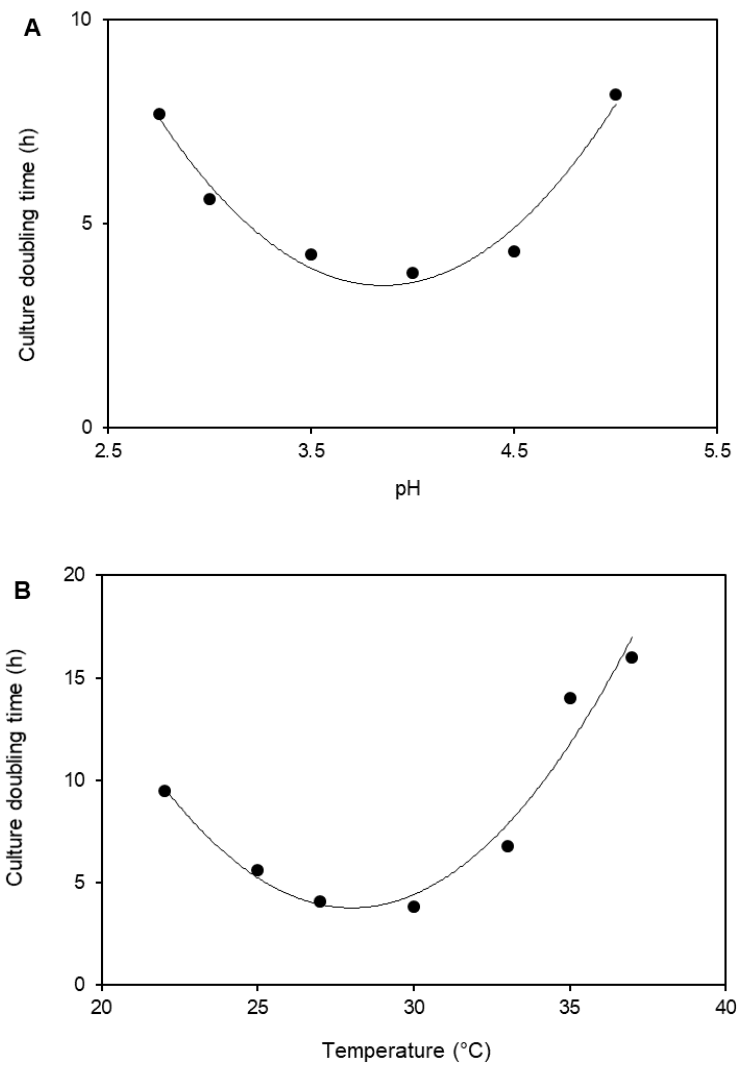
Figure 1. E ff ect of ( A ) pH (at 30 ◦ C) and ( B ) temperature (at constant pH of 4.0) on the growth of Figure 1. Effect of ( A ) pH (at 30 °C) and ( B ) temperature (at constant pH of 4.0) on the growth of isolate isolate IT2.